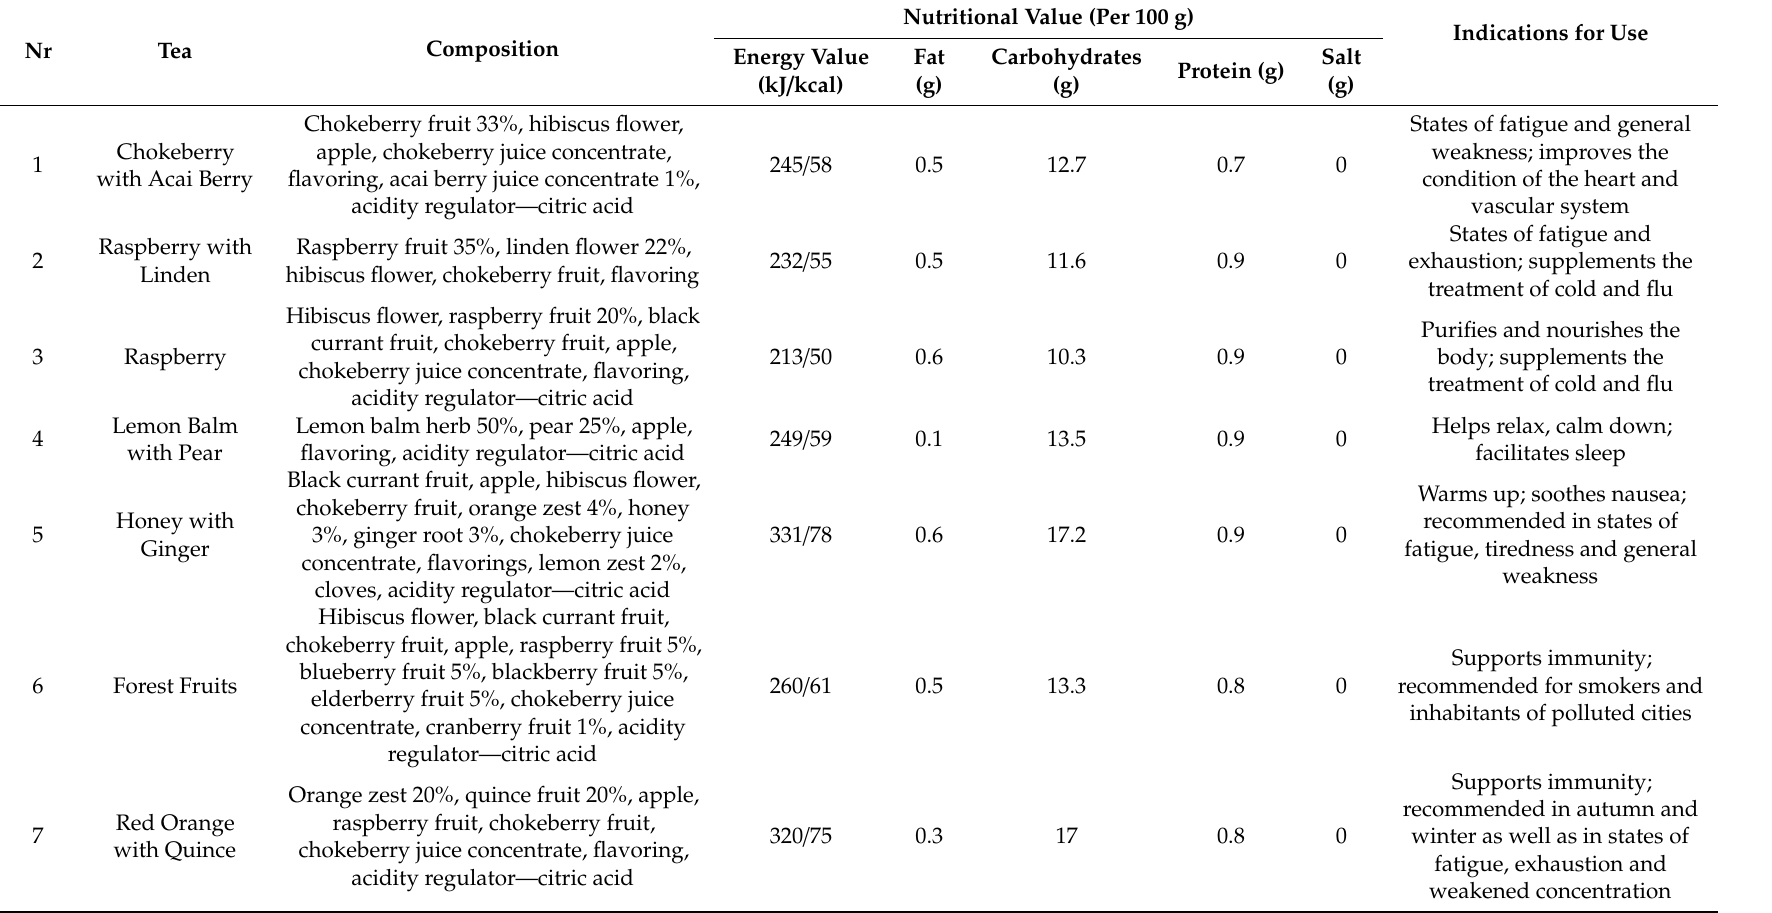
Table 1. The composition, nutritional value, and indications for use of the analyzed fruit teas as declared by their